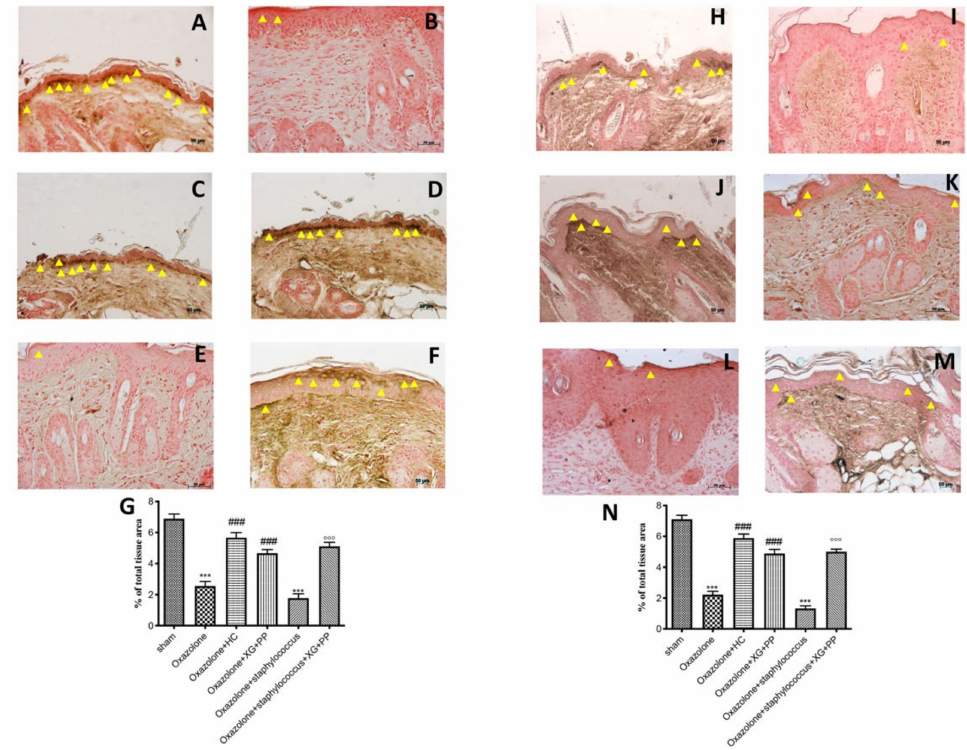
Figure 3. E ff ects of xyloglucan and pea protein on ZO-1 and occludin expressions: The ZO-1 and occludin expressions were analyzed using immunohistochemistry. Basal expressions of ZO-1 ( A , G ) and occludin ( H , N ) have been found in the tissues of sham-operated mice; oxazolone treatment reduced these expressions ( B , G ; I , N ), whereas hydrocortisone administration (2.5 mg / mice) restored the expressions to almost basal levels in both in vivo models ( C , G and J , N respectively). Also, XG + PP treatment increased the positive staining in oxazolone treatment and in oxazolone + S. aureus infection for both ZO-1 ( D , G and F , G respectively ) and occludin ( K , N and M , N respectively). Moreover superinfection induced by coadministration of oxazolone and S. aureus significantly reduced the positive staining of ZO-1 ( E , G ) and occludin ( L , N ). *** p < 0.001 vs. sham; ### p < 0.001 vs. oxazolone; ◦◦◦ p < 0.001 vs. oxazolone +